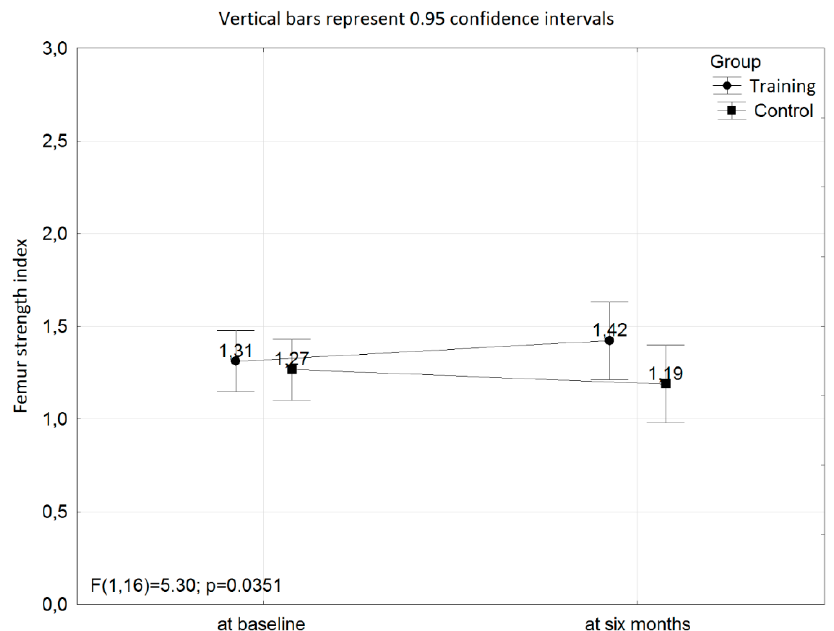
Figure 1. The interaction with respect to the femur strength index at baseline and after six months of the training program between the training and control